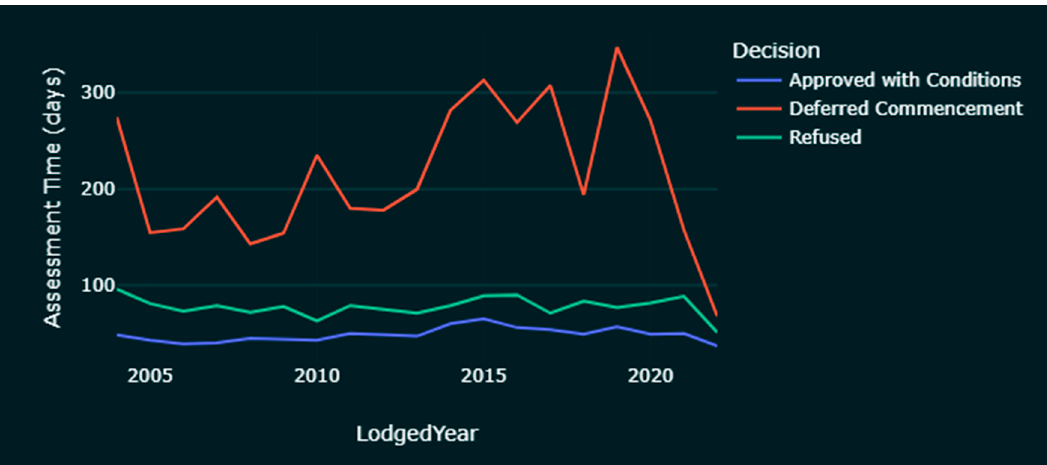
Figure 41. Proportion of different types of determination (2004–2022).